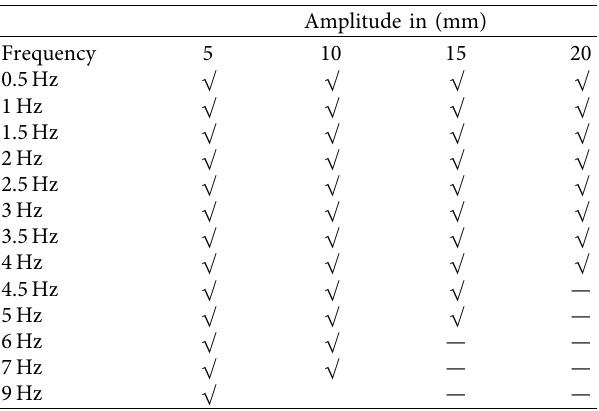
Figure 2: Experimental setup. Table 1: Specification of